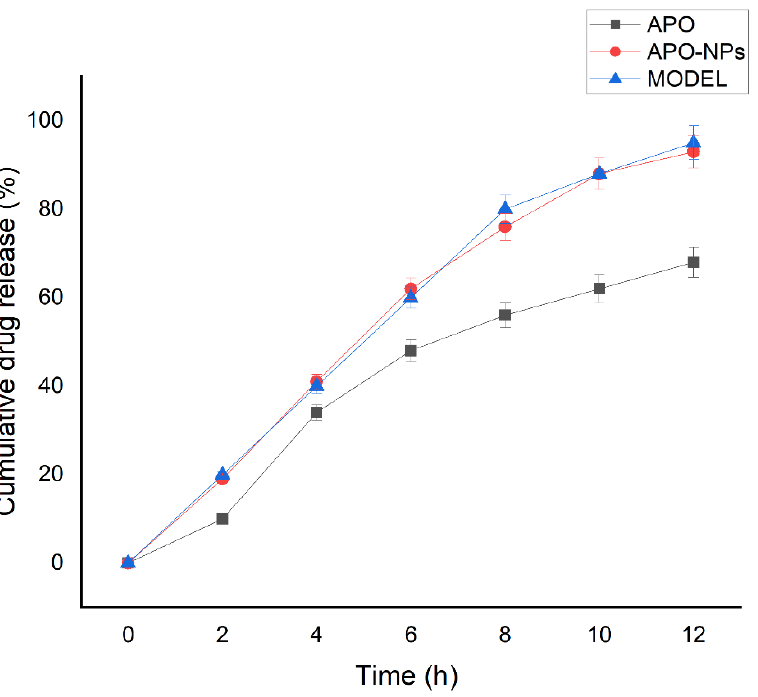
Figure 5. The comparative analysis of cumulative drug release (CDR %) of APO and APO-NPs.